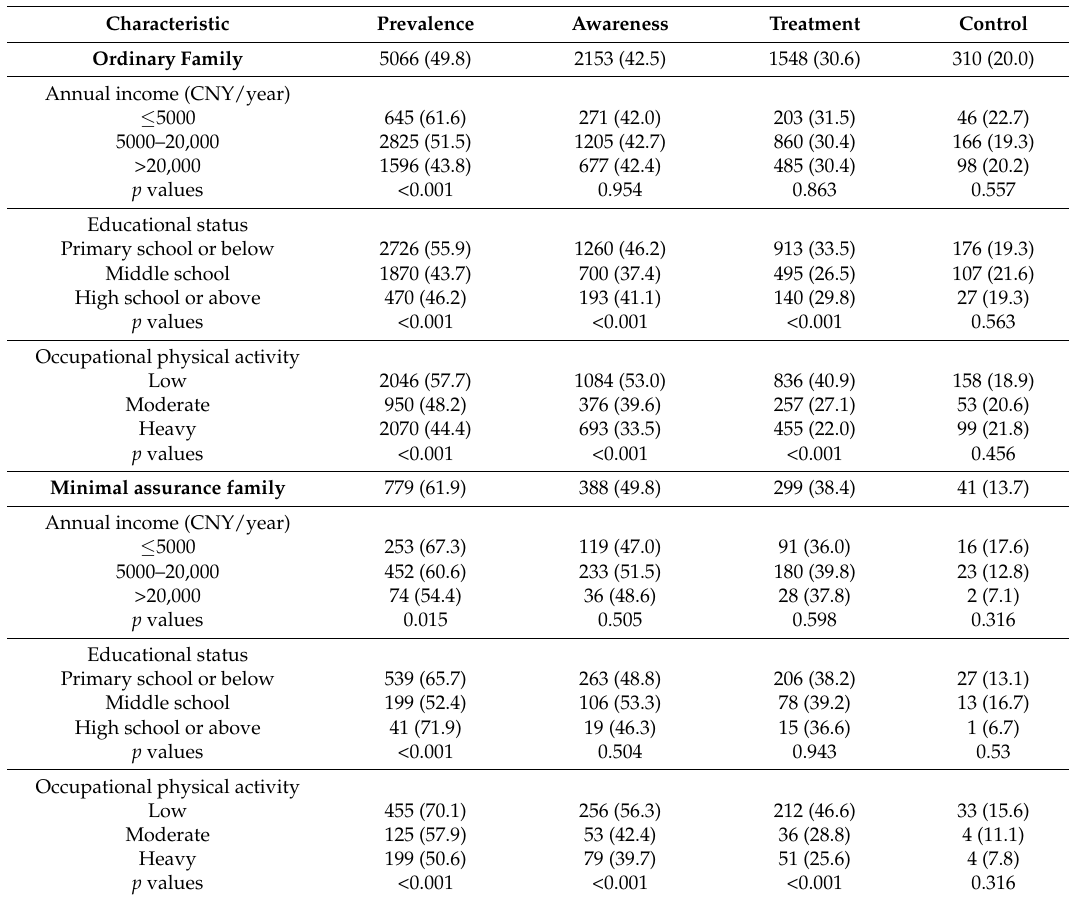
Pearson chi-square test was used to detect differences among the socioeconomic status groups.